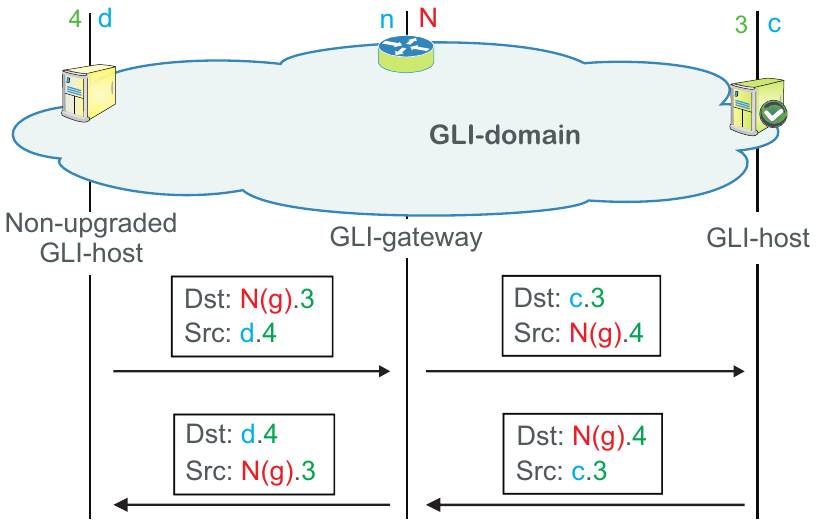
Figure 9. Reflection of local traffic: classic IPv6-GLI-node 4 communicates with GLI-node 3 via global addresses. The gateway of their GLI-domain reflects the traffic between the hosts to ensure addressing